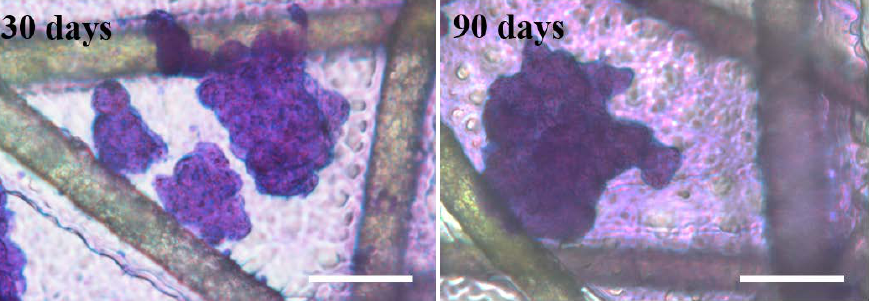
Figure 4. Stability of gelatin@NWF scaffold. DU 145 cells were cultured on the scaffolds, which were stored for 30 and 90 days, respectively, scale bar = 50 µm. stored for 30 and 90 days, respectively, scale bar = 50 µ